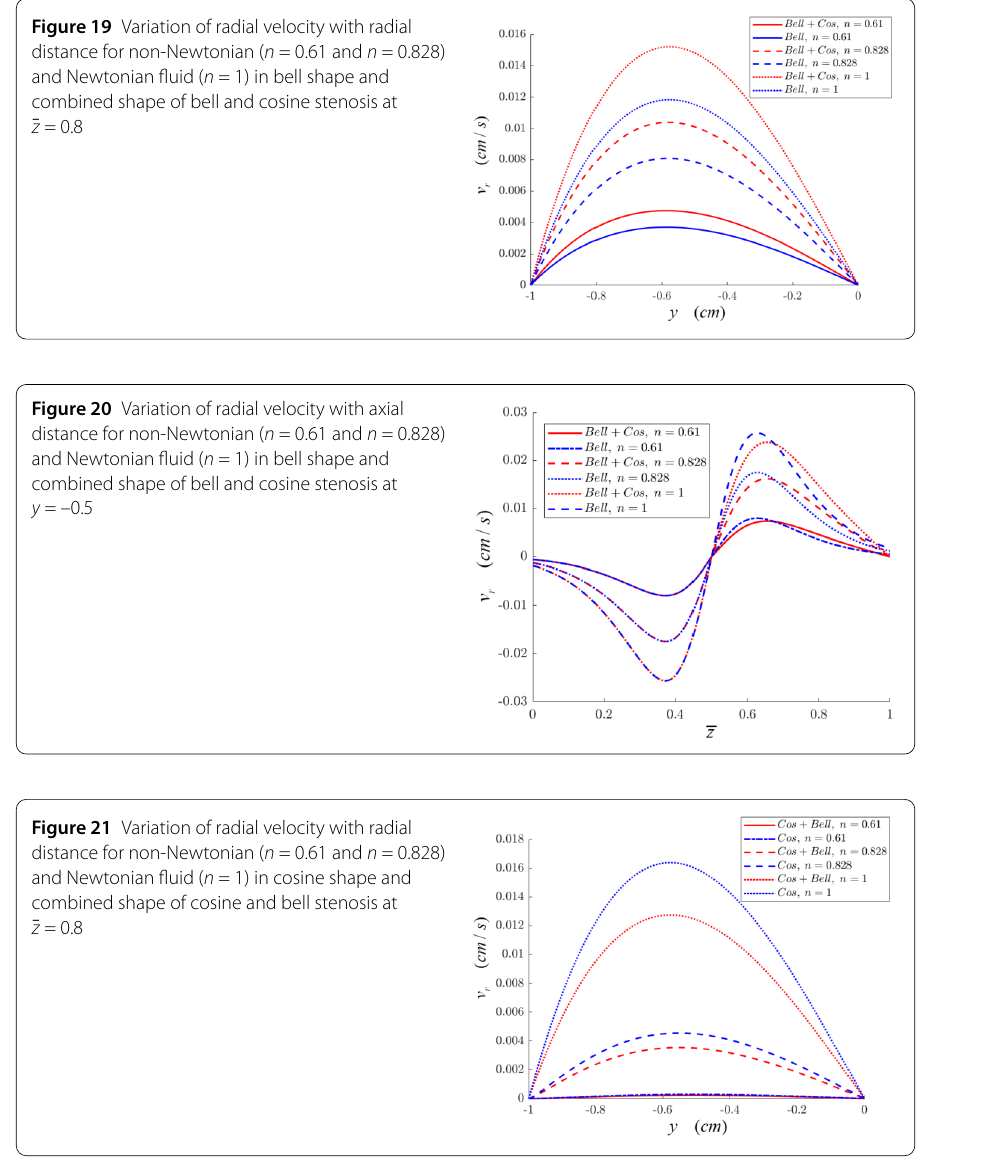
Figure 19 Variation of radial velocity with radial distance for non-Newtonian ( n = 0.61 and n = 0.828) and Newtonian fluid ( n = 1) in bell shape and combined shape of bell and cosine stenosis at ¯ z = 0.8